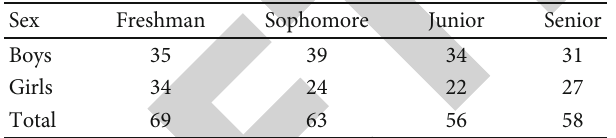
Table 2: Composition of students participating in the